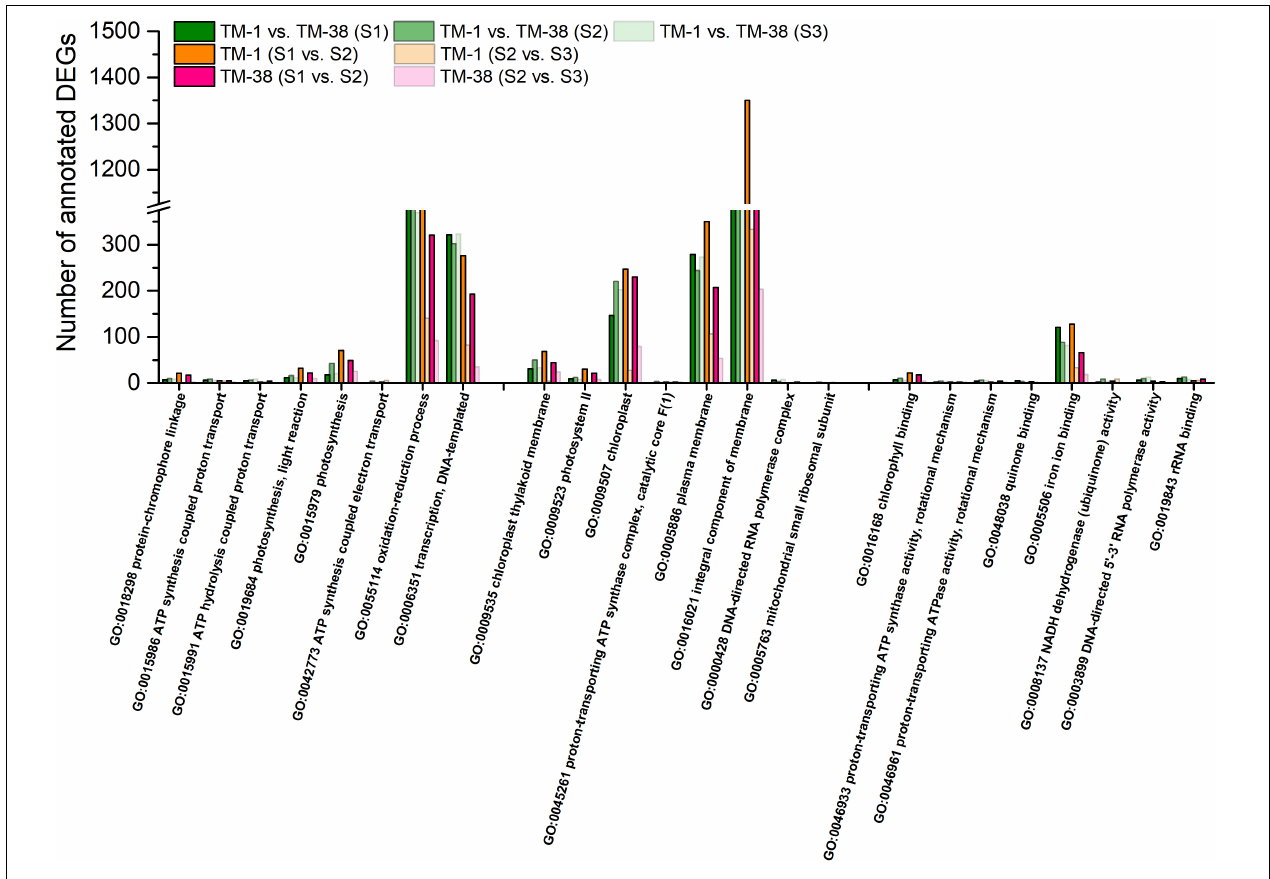
FIGURE 4 | Fisher’s exact test for the significant (top eight) enrichment analysis of Gene Ontology (GO) terms of the biological process, cellular components, and molecular function categories of the annotated DEGs in TM-1 and TM-38 at three developmental stages.